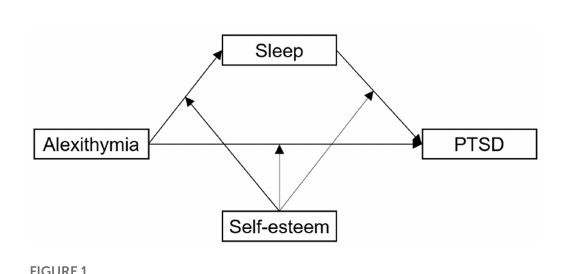
FIGURE 1 Hypothetical moderated mediation model. PTSD, posttraumatic stress